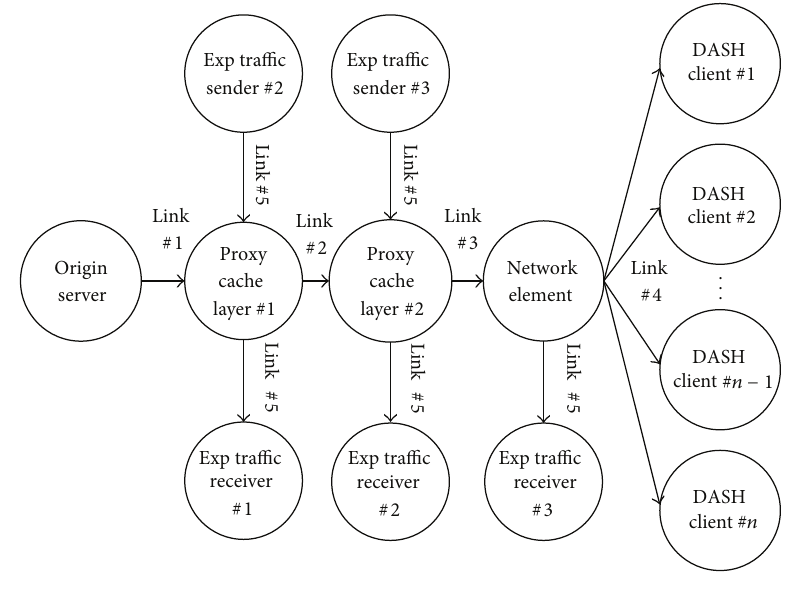
Figure 4: Network topology. Table 2: Two sets of simulation